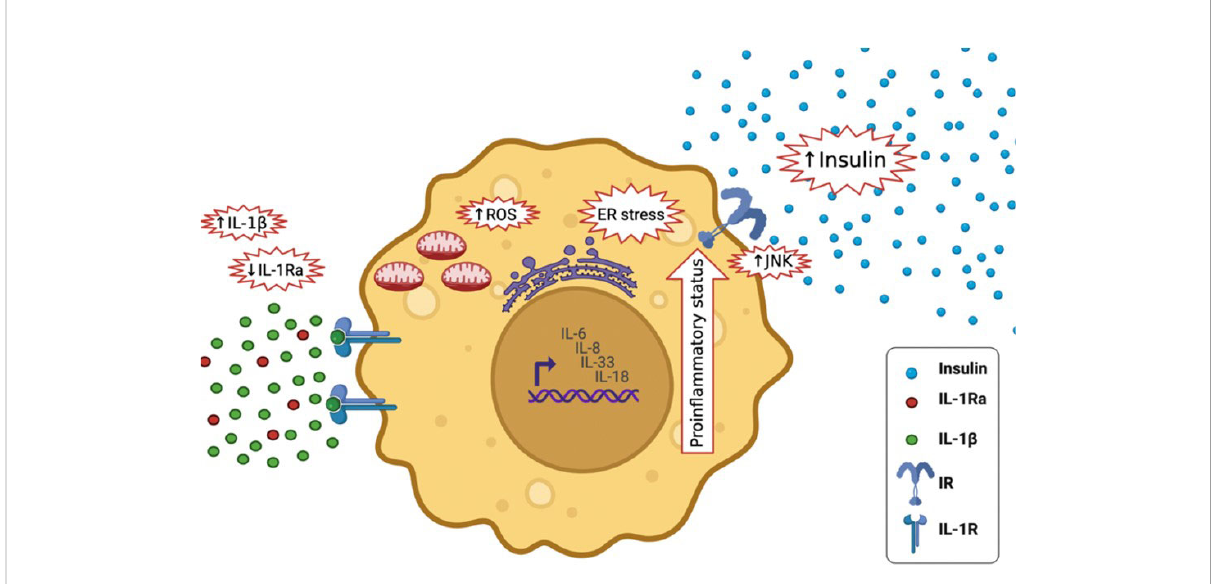
FIGURE 1 IL-1 b Synthesis and Regulation. NLRP3 in fl ammasome is activated via two signals; the priming signal which activates the transcription factor NF- k B leading to the upregulation of NLRP3, pro-IL-1 b and IL-1Ra mRNA and the activation signal which stimulates NLRP3 in fl ammasome complex assembly and activation, assembled caspase-1 undergoes self-cleavage and activation. Active caspase-1 triggers the activation and release of IL- 1 b . IL-1 b regulates its own synthesis in an autoregulatory feed-back loop